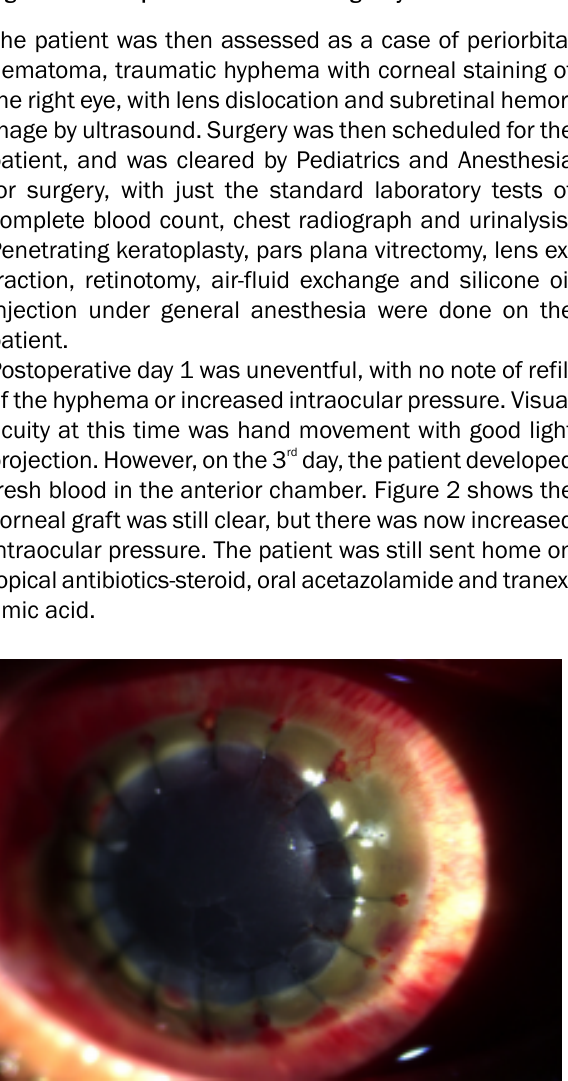
complete blood count, chest radiograph and urinalysis.